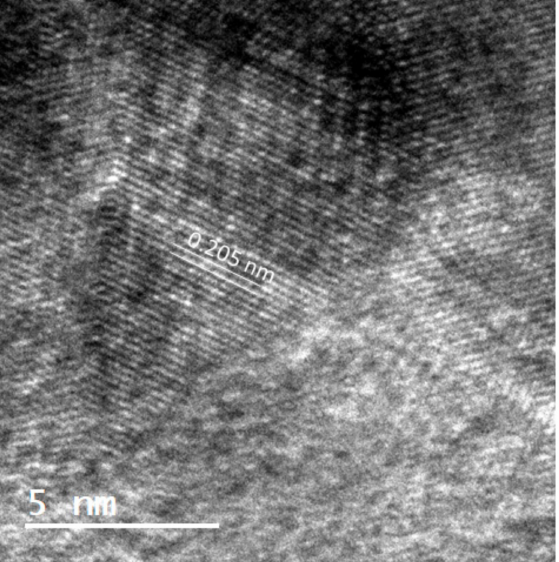
Figure 8. High-resolution TEM showing diamond crystallites with interplanar spacing of 0.205 nm, corresponding to the (111) plane orientation of diamond.